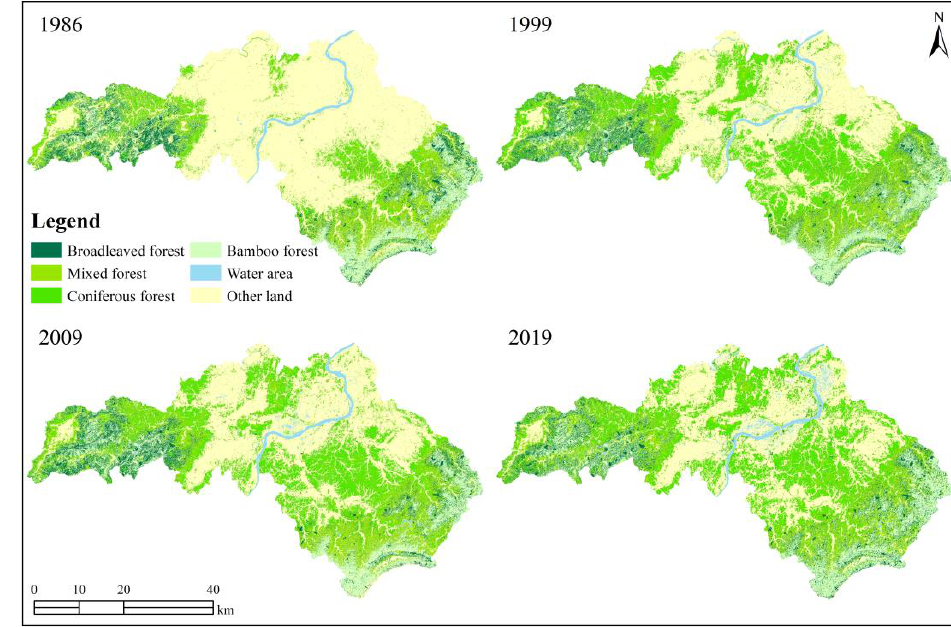
Figure 3. Distribution map of forest types of Taihe County from 1986 to 2019.